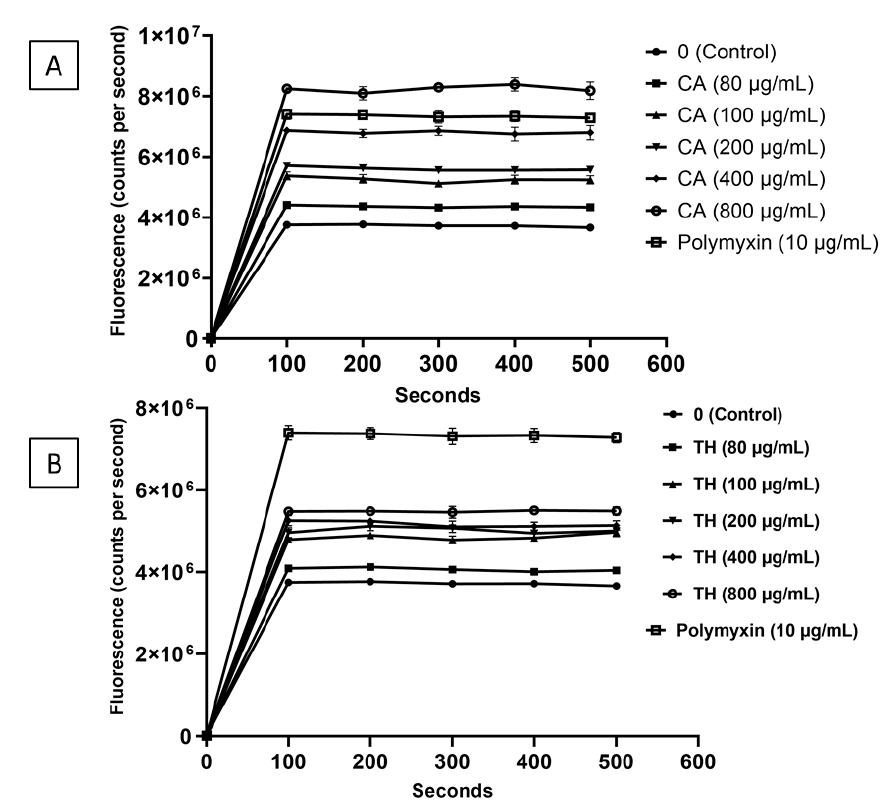
Figure 4. Release of the intracellular potassium ions from desiccation-adapted Salmonella Tennessee E2007000304 when treated with different concentrations of carvacrol (panel ( A )) or thymol (panel ( B )); polymyxin (10 µg/mL) was used as a positive control. The release of intracellular K + was meas- ured as changes in fluorescence at 505 nm. Each data point represents mean ± standard deviation.